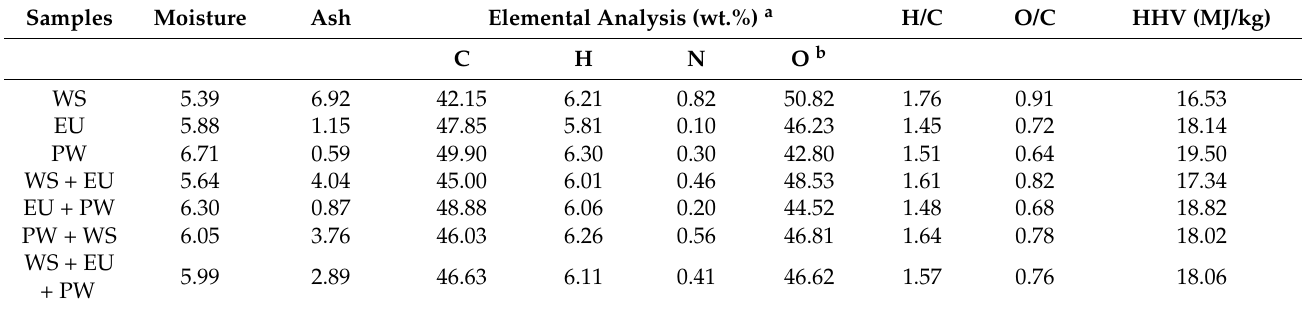
Table 2. Elemental analysis of the